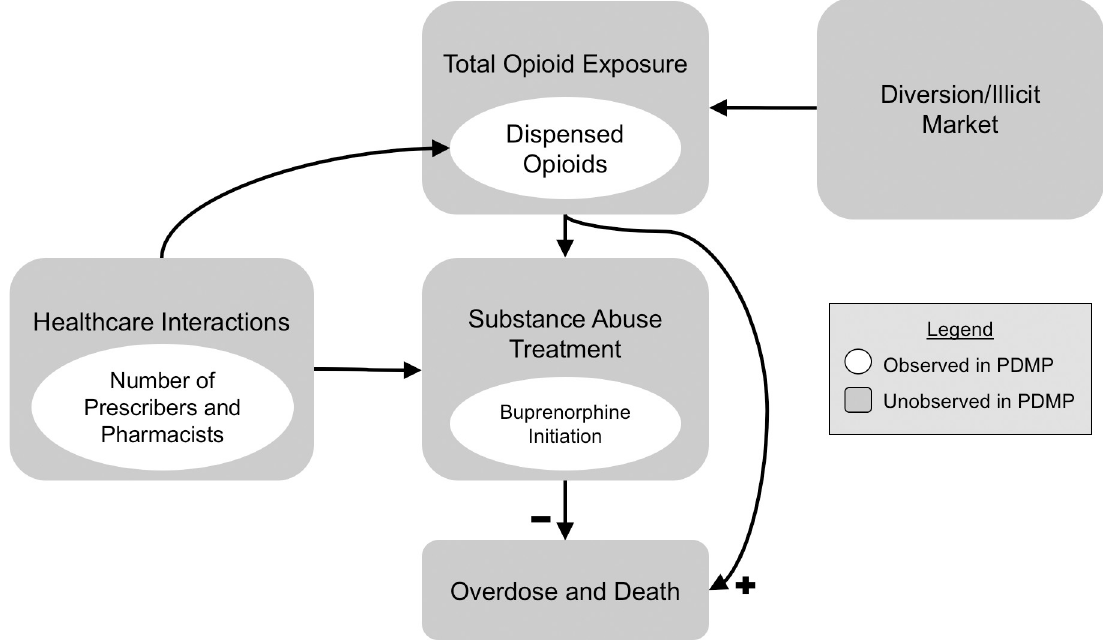
Fig 1. Abbreviated directed acyclic graph of buprenorphine initiation and prescription drug monitoring program data elements. Elements shown in gray squares cannot be directly observed in Prescription Drug Monitoring (PDMP) data, while elements in white ovals can be